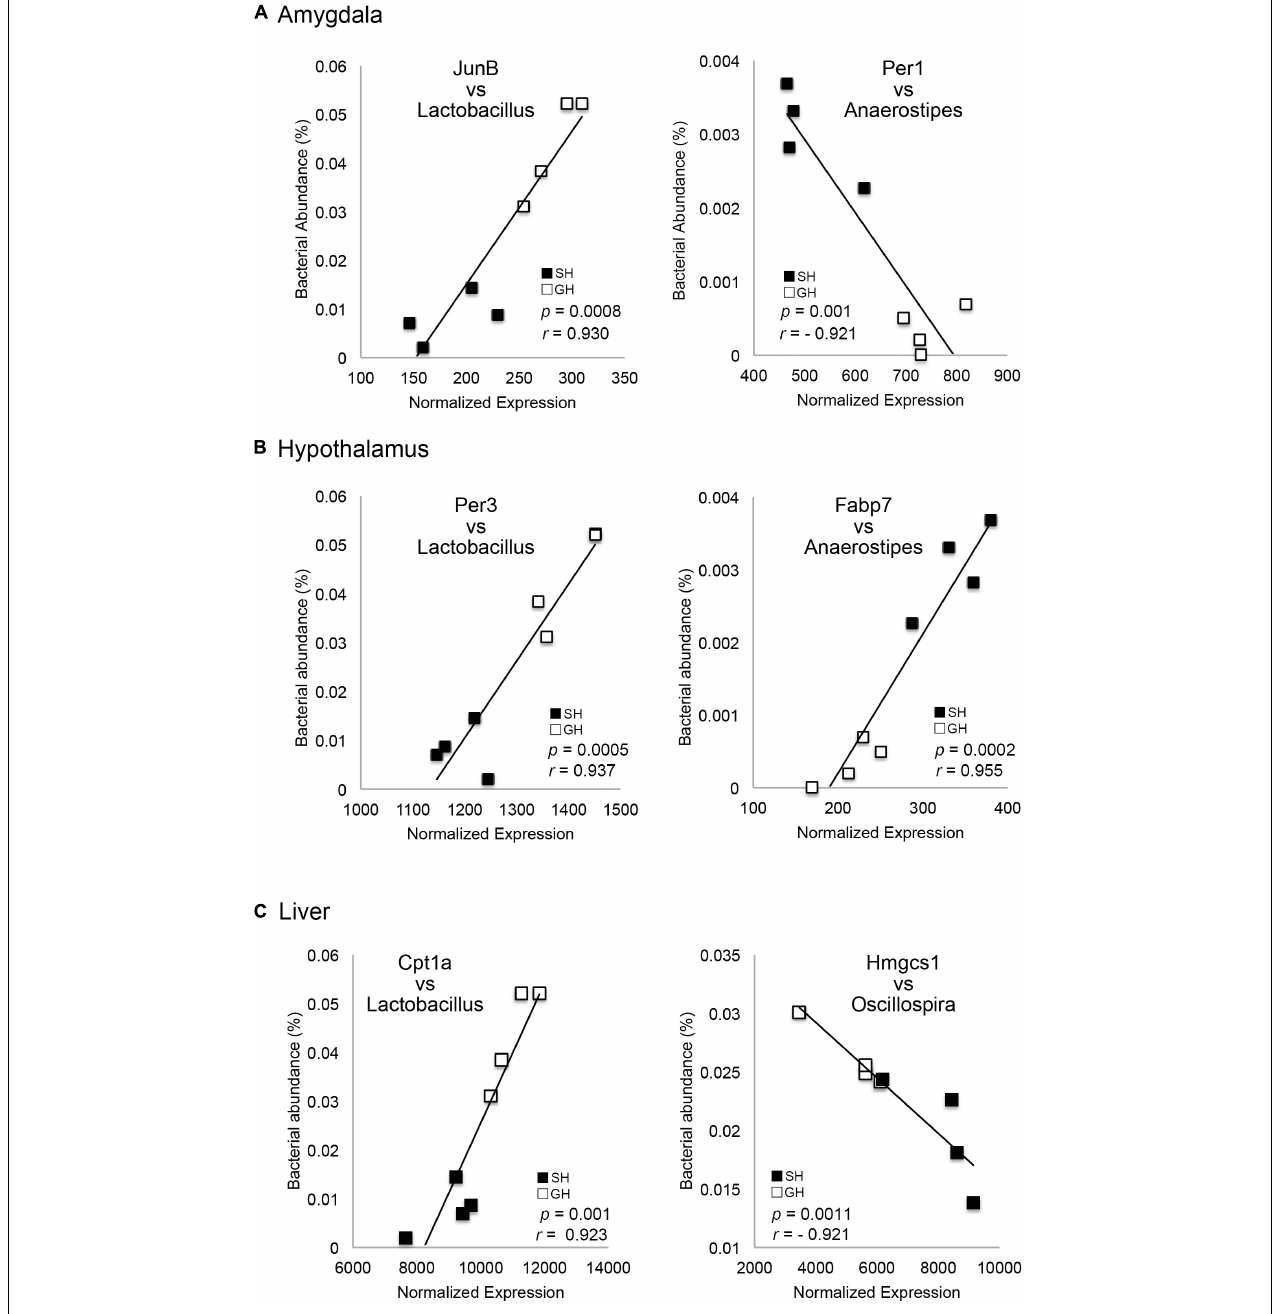
FIGURE 4 | Correlation between the gene expression levels and the bacterial occupancy. The plot of each gene expression level in the amygdala (A) , hypothalamus (B) , or liver (C) against Lactobacillus, Anaerostipes or Oscillospira occupancy ( n = 4 for each group). Genes were JunB Proto-Oncogene (JunB), Period 1 (Per1), Period 3 (Per3), Fatty acid-binding protein 7 (FABP7), Carnitine palmitoyltransferase 1A (CPT1A), and 3-Hydroxy-3-Methylglutaryl-CoA Synthase 1 (HMGCS1).